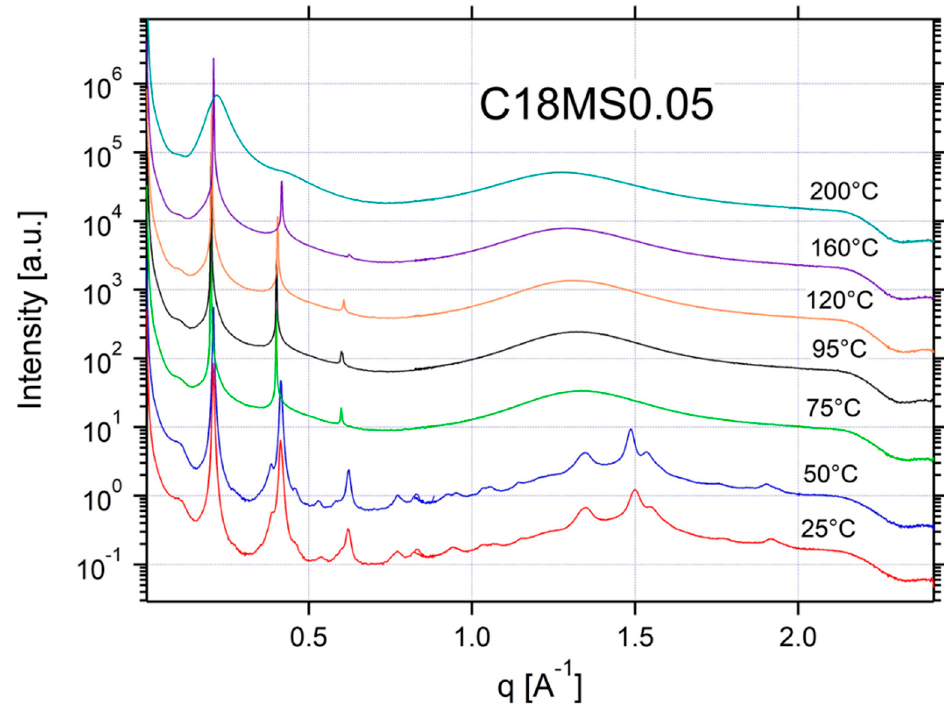
Figure A11. SAXS and WAXS data for 0.05:1 C18MS:C18LiTFSI.